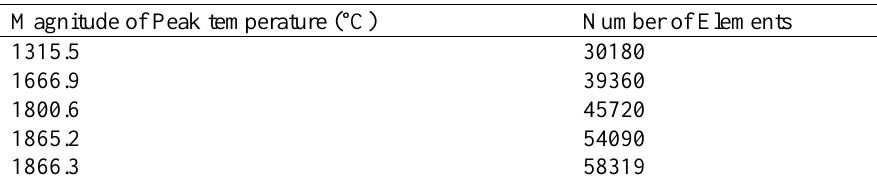
Table 4. Recorded peak temperature during FE analysis for a different number of elements.